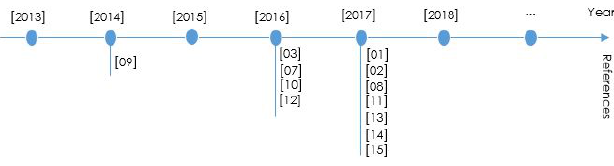
Figure 1. Qualitative Analyzes, Proposed Frameworks and/or Comparative Studies on the Smart City Concept